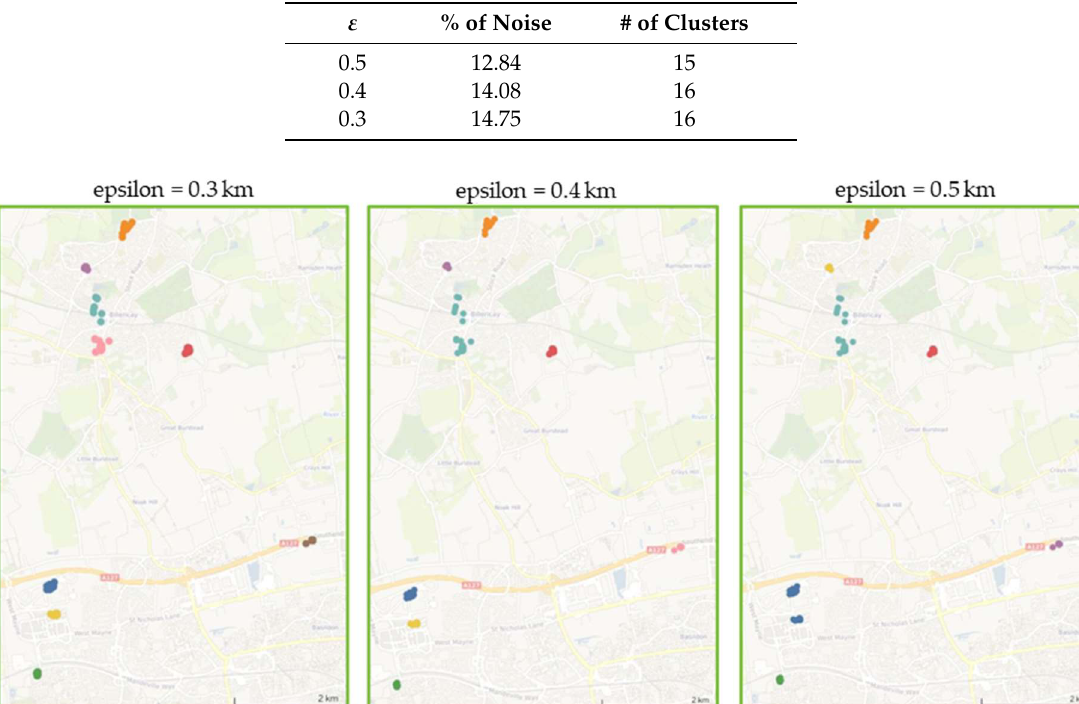
Table 3. DBSCAN (Density-Based Spatial Clustering of Applications with Noise) parameters definition.